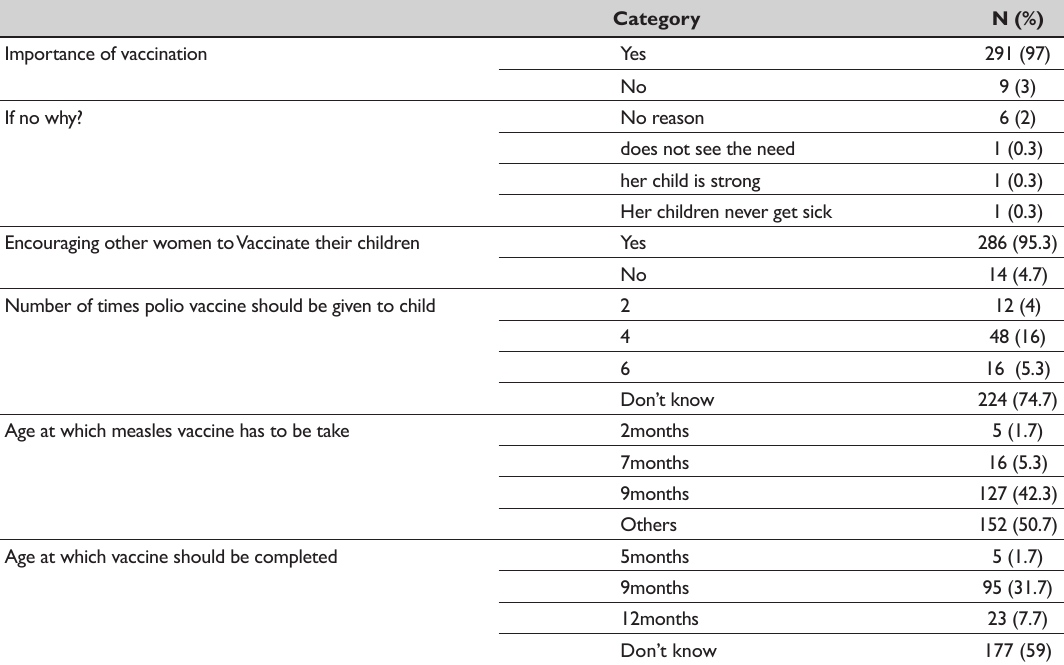
Table 4: Indicators used to assess knowledge on vaccination of caregivers